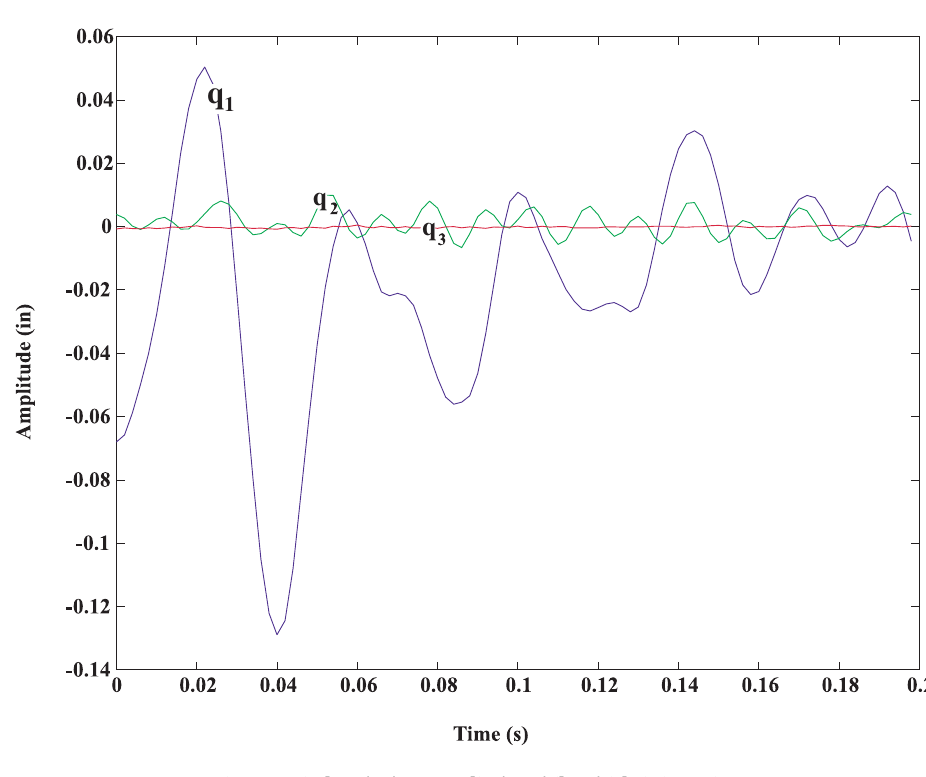
Fig. 4. Typical mode shape amplitudes while vehicle is in